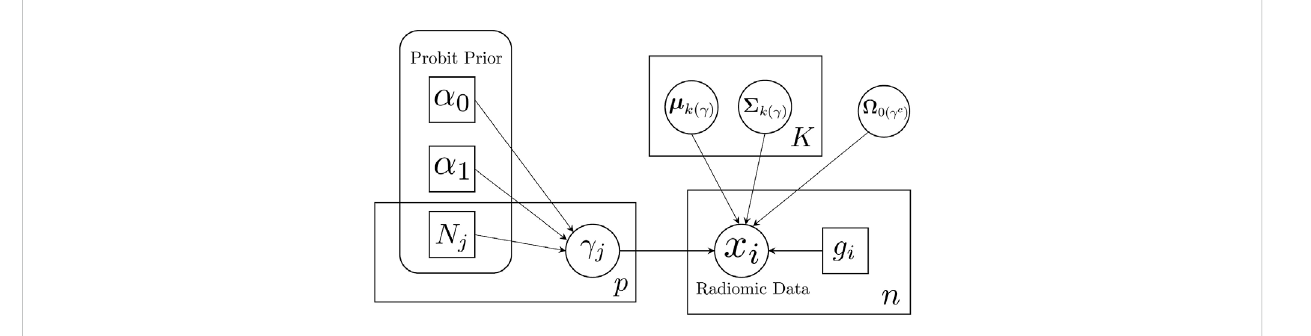
FIGURE 2 Schematic illustration of sparse Bayesian classi fi cation model. Feature-speci fi c prior information is incorporated through the probit